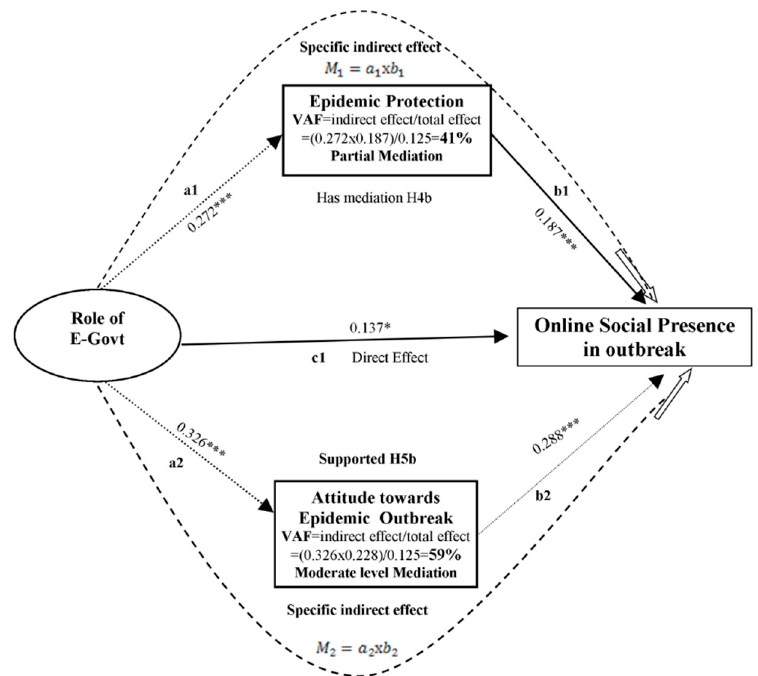
Figure 5. Magnitude of mediation of H4b and H5b .